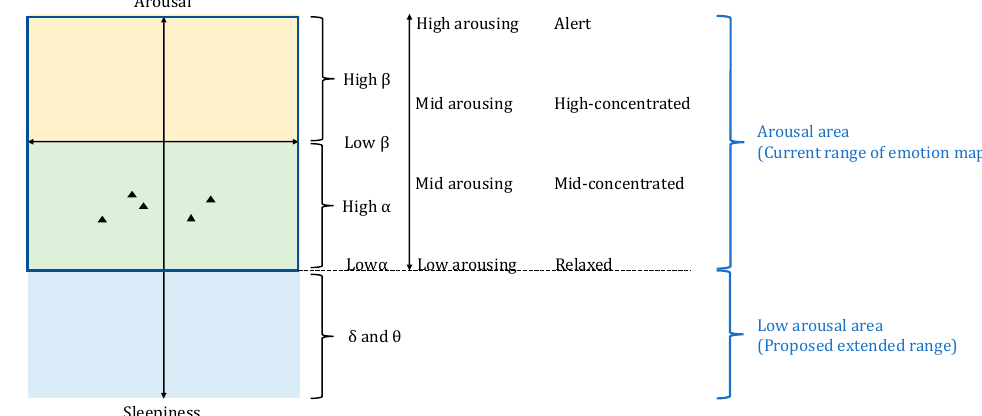
Figure 14. Proposed new range of arousal level in an emotion map expanding to low arousal area to visualize psychological states affected by olfactory stimuli. The triangles indicate the olfactory stimuli plo tt ed on emotion map.